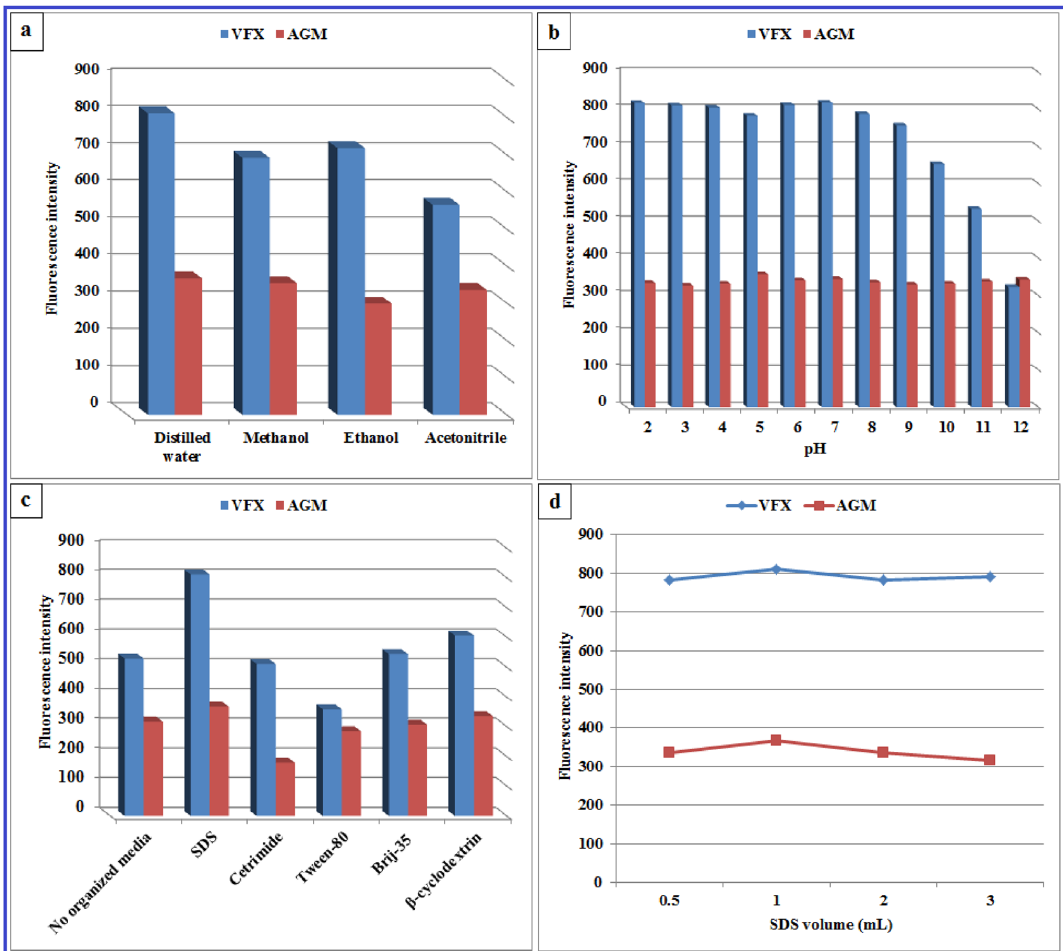
Figure 4. Influence of different diluting solvents ( a ), pH ( b ), organized media ( c ), and SDS volume ( d ) on the SFI of 1000.0 ng/mL VFX and 100.0 ng/mL